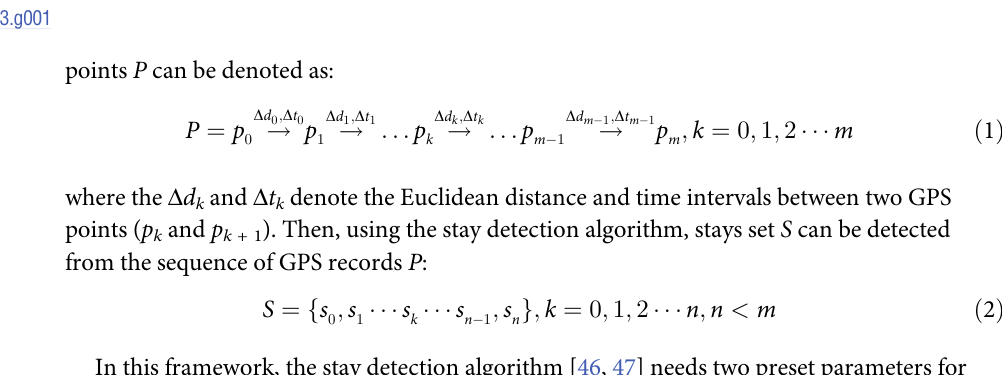
Fig 1. Analysis framework.